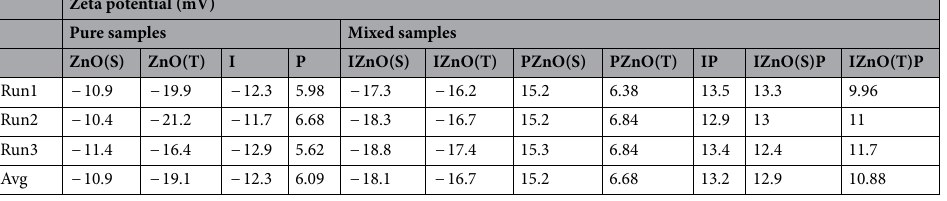
Table 2. Measured Zeta potential (DLS data) of the